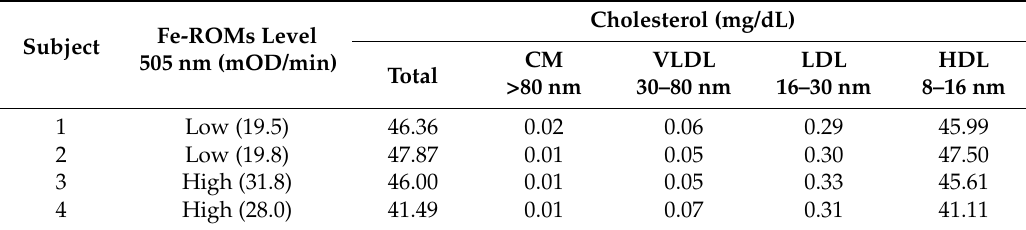
Table 2. The cholesterol concentrations of the major classes of lipoproteins in four plasma samples containing low or high levels of Fe-ROMs.